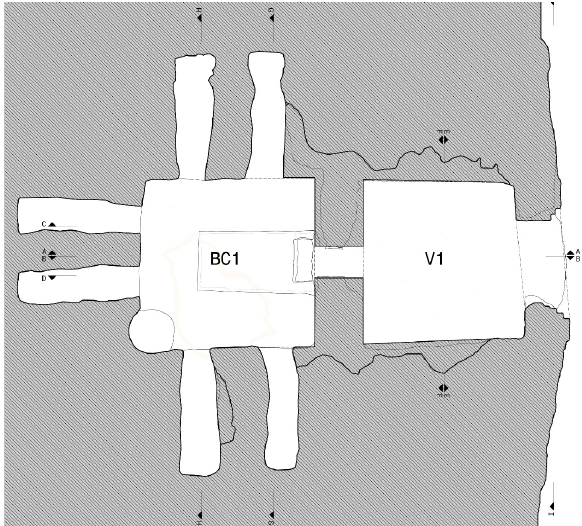
Figure 7. Spatial hypothesis of the grave.